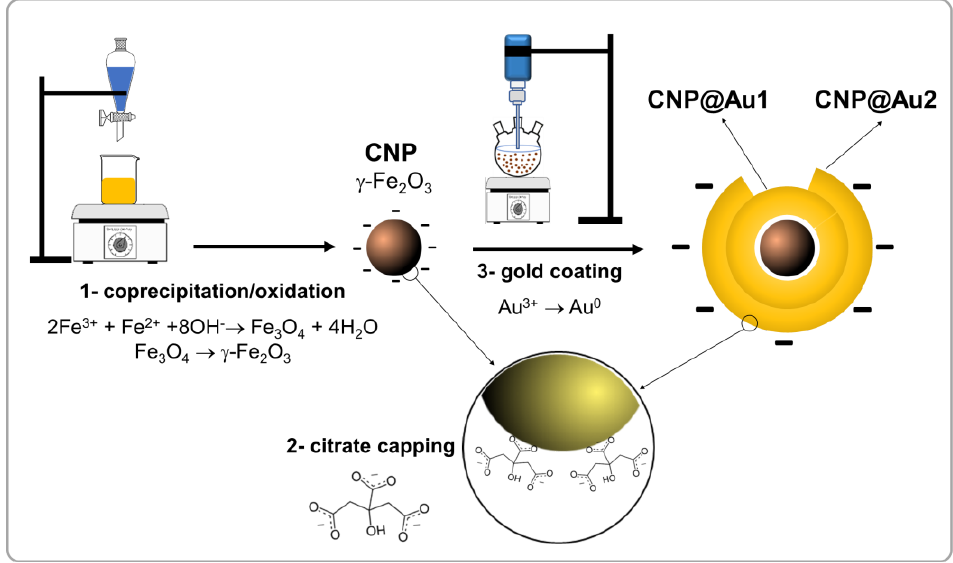
Figure 1. A diagram of the synthesis of the citrate-capped (CNP) and gold shelled (CNP@Au1